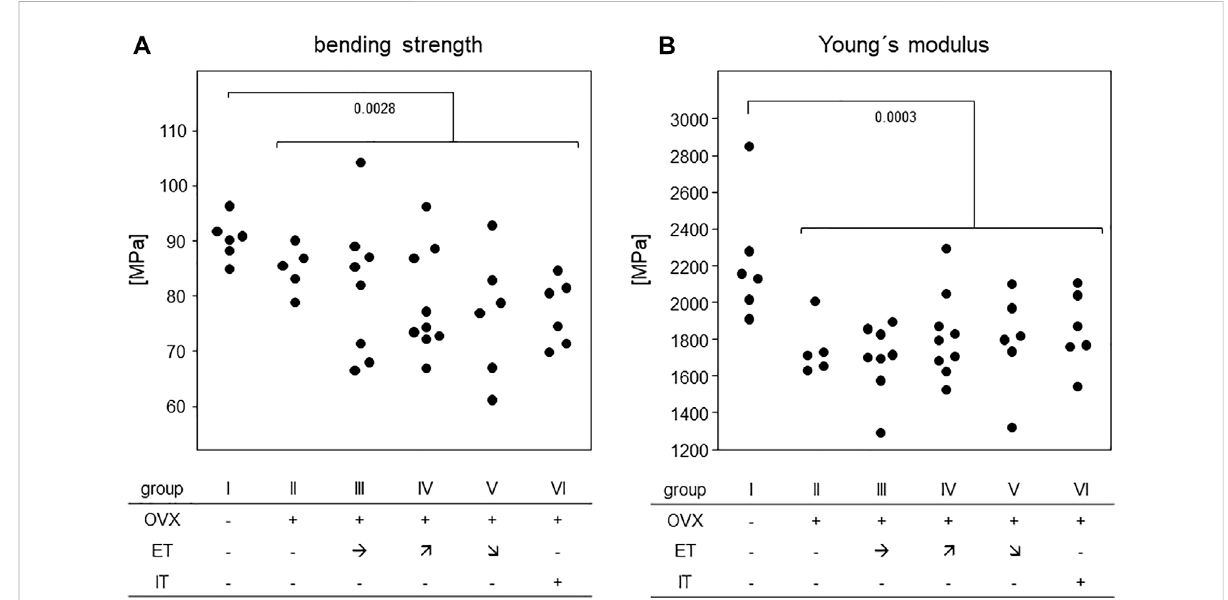
FIGURE 5 Treadmill training did not compensate for OVX-induced loss of bone stability. Dot blots summarize (A) the bending strength and (B) Young`s Modulus. Statistics were calculated by Mann-Whitney U-test and statistically signi fi cant differences are indicated by p